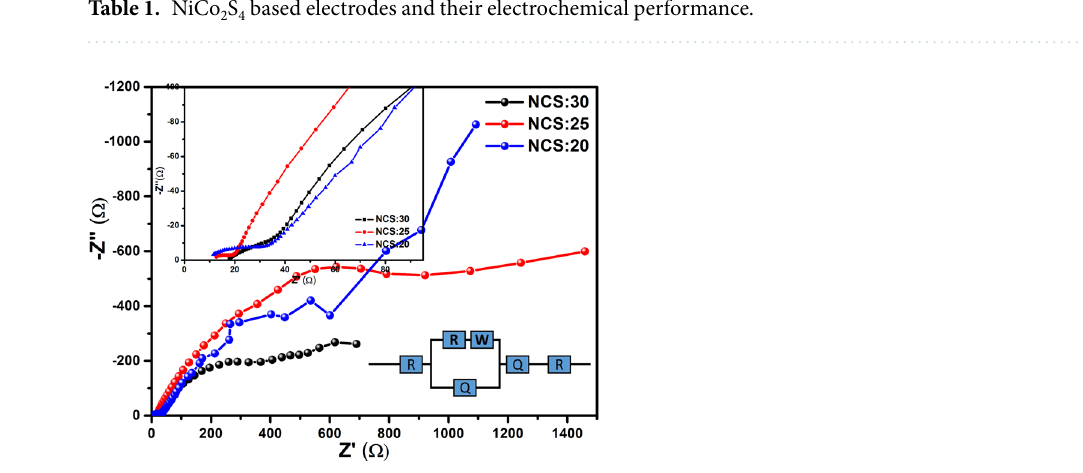
Figure 6. Nyquist plots for the NCS:30, NCS:25, and NCS:20 electrodes at 5 M KOH electrolyte. (Inset: Proposed equivalent circuit for EIS